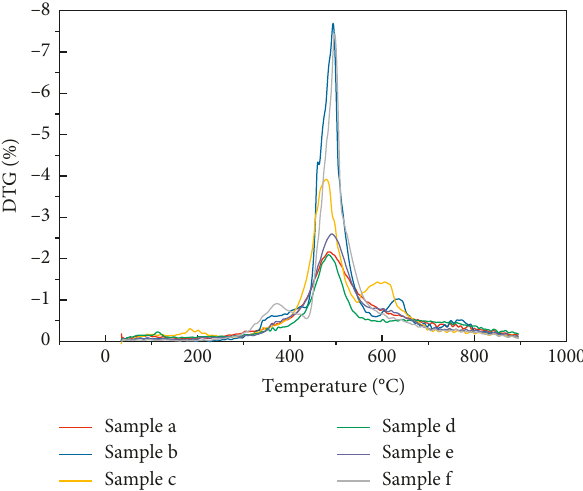
Figure 2: DTG analysis of coal